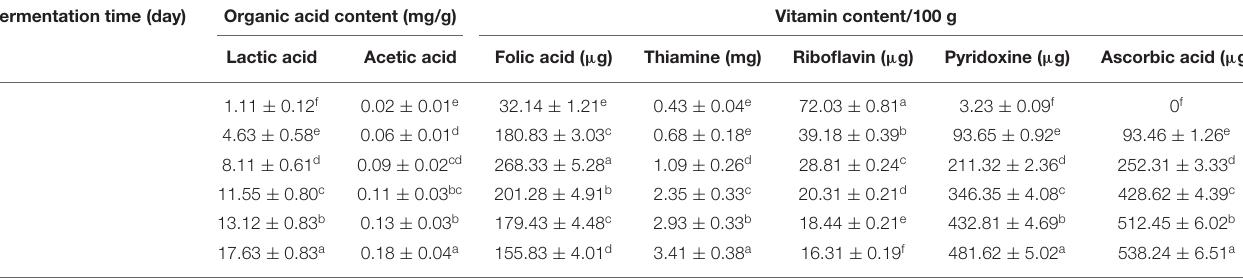
TABLE 2 | Lactic acid, acetic acid, and hydrosoluble vitamins content of haria. Fermentation time